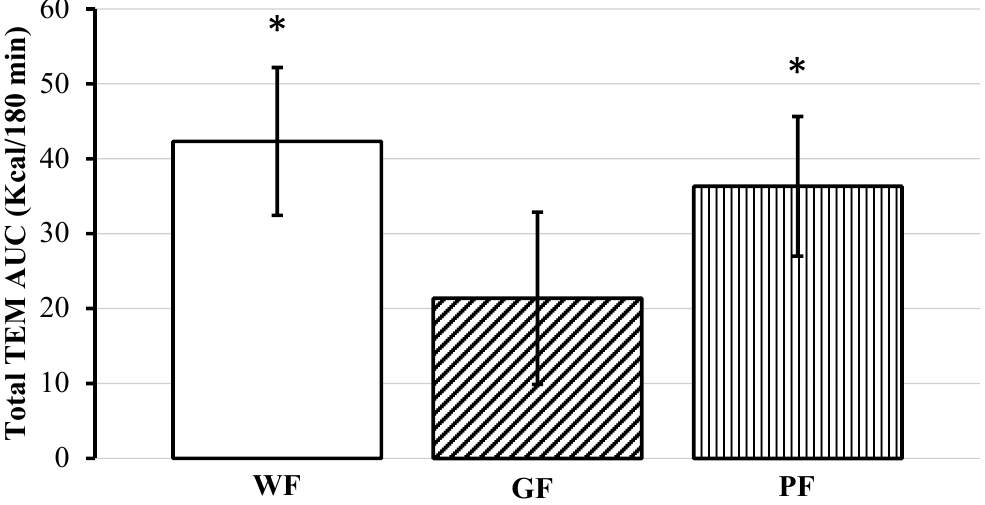
Figure 3. Comparison of total thermic effect of meal (TEM) area under the curve (AUC) for the 180–minute postprandial period following after consumption of whole foods (WF), gluten-free (GF) and processed (PF) meals. * Significant difference compared to GF p < 0.05. Data displayed as means ±95% confidence intervals.